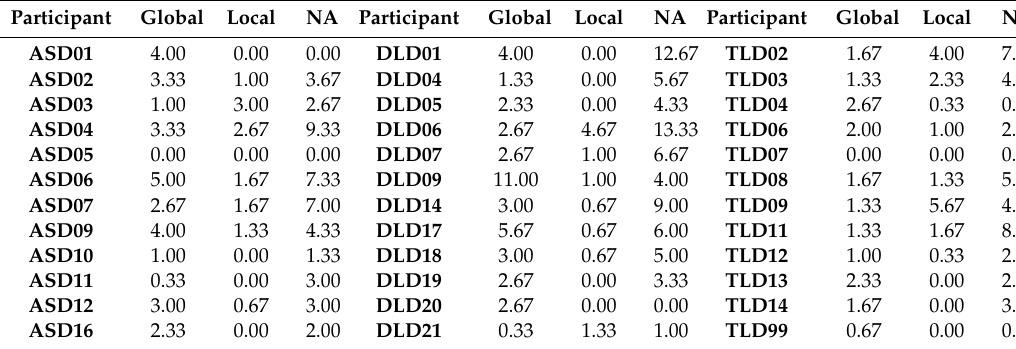
Table 4. Mean number of semantic features for each participant for each processing